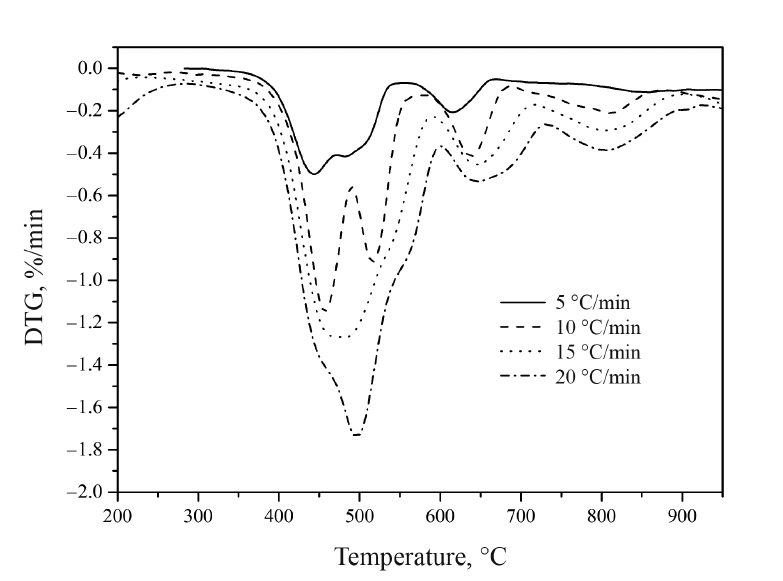
Fig. 2. DTG curves of OS-Co samples at different heating